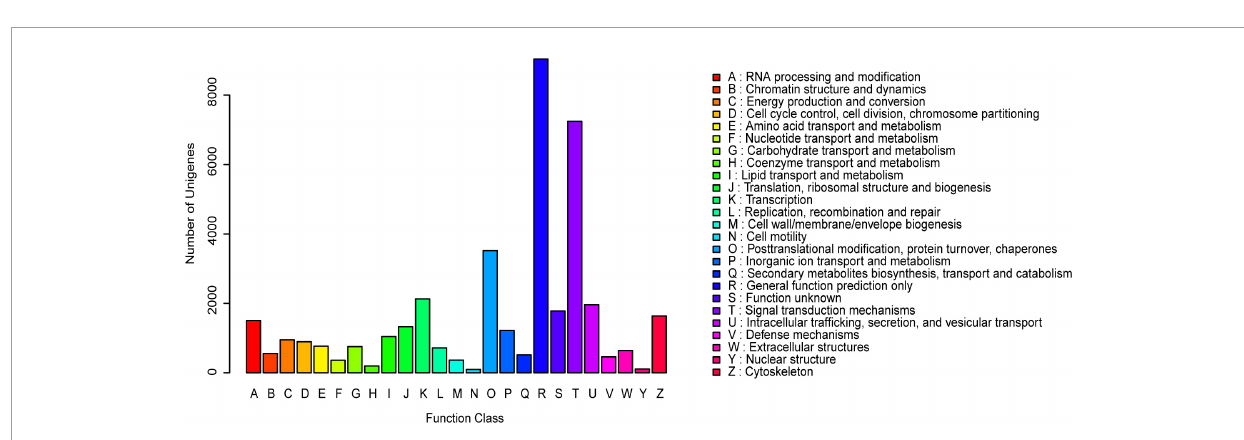
FIGURE2 Gene ontology (GO) classification of the assembled unigenes. The three main GO categories were displayed in different colors (Red represented the biological processes, green represented the cell components, and blue represented the molecular functions). The horizontal axis represented GO terms name, and the vertical axis represented the gene number and percentage of